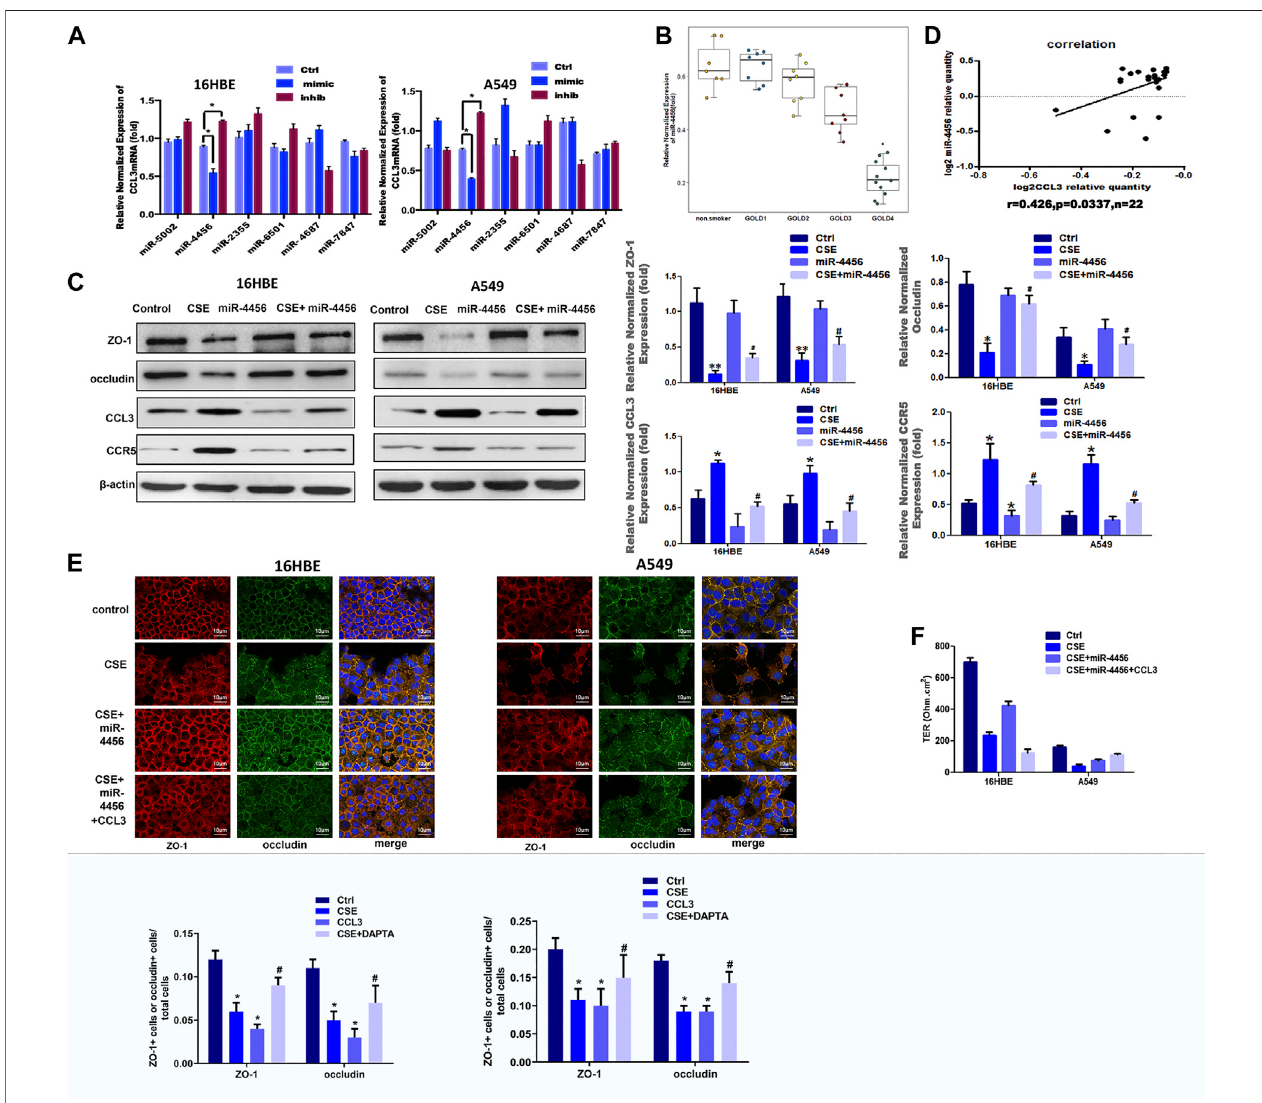
FIGURE 3 | Identi fi cation of miR-4456 as an upstream signal of CCL3 induced-tight junction injury (A) Real-time PCR screen in 16-HBE cells (left panel) and A549 cells (right panel) for miRNAs that could target CCL3 mRNA. CCL3 mRNA expression levels were normalized to GAPDH expression. n (cid:2) 3, * p < 0.05, vs. the control group. The expression levels were normalized to the expression of GAPDH (B) Baseline expression of miR-4456 according to COPD grade. * p < 0.05 vs. the non- smoker group (( n (cid:2) 48. non-smokers:8, GOLD 1:9, GOLD2: 9, GOLD3:10, GOLD4:12) (C) Western blot analysis of ZO-1, occludin, CCL3, and CCR5 protein expression in the four groups: 1) Control (PBS 10 mg ml − 1 ), 2) CSE (10 mg ml − 1 ), 3) miR-4456, and 4) CSE (10 mg ml − 1 )+miR-4456 mimics in 16HBE cells and A549 cells. n (cid:2) 3,** p < 0.01,vs.thecontrolgroup,* p < 0.05,vs.thecontrolgroup,# p < 0.05,vs.theCSEgroup.Proteinexpression wasnormalized to β -actin (D) Correlation analysisofmiR-4456andCCL3mRNAlevelsbyPearsoncorrelationcoef fi cientfromatotalof22COPDperipheralbloodsamples( n (cid:2) 22) (E) TightjunctionproteinsZO- 1 (red), occludin(green) and merged (blue+orange) werestained byimmuno fl uorescence in thefour groups: 1) Control (PBS10 mg ml − 1 ),2) CSE (10 mg ml − 1 ),3)CSE (10 mg ml − 1 )+miR4456, and 4) CSE (10 mg ml − 1 )+miR4456 mimics + CCL3 (10 mg ml − 1 ) in 16HBE cells (left panel) and A549 cells (right panel). Presented as means ± standarderror. n (cid:2) 3,* p < 0.05,vs.thecontrolgroup,** p < 0.01,vs.thecontrolgroup,# p < 0.05,vs.theCSEgroup, △ p < 0.05,vs.theCSE+miR-4456group.Dataare representative of three independent experiments. Scale bar (cid:2) 10 µm (F) TER in the four groups same as Figure-3Eis shown asa function test on 7 days after plating the airway epithelial cells on coated permeable fi lters. Presented as means ± standard error. n (cid:2) 3, * p < 0.05, vs. the control group, ** p < 0.01, vs. the control group, # p < 0.05, vs. the CSE group, △ p < 0.05, vs. the CSE + miR-4456 mimics group.